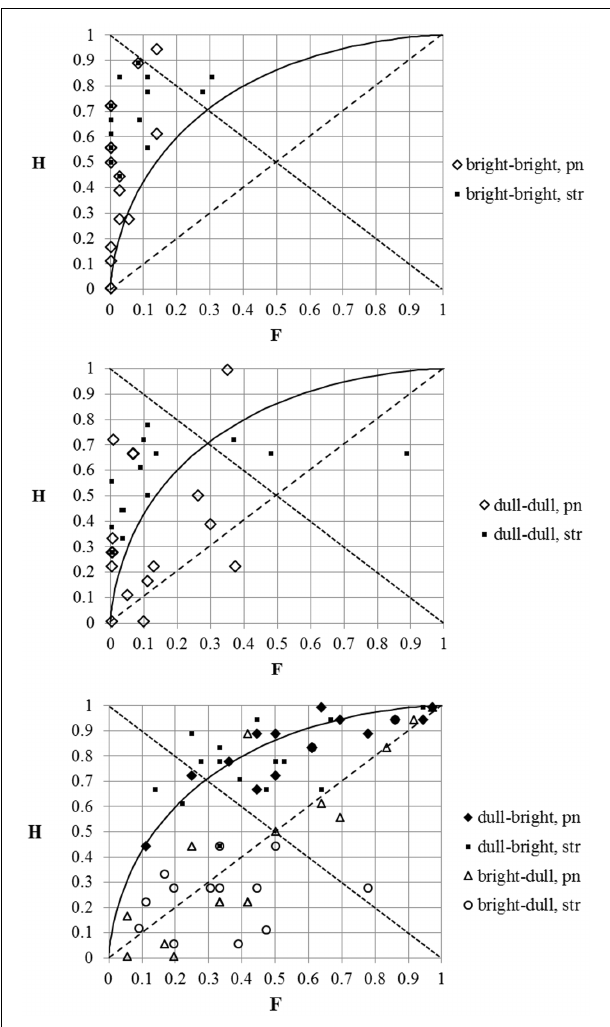
FIGURE 7 | The same as Figure 6, but only the replies to the stimulus-pairs with (cid:2) F 0 = 40 cents and zero cents were included in the